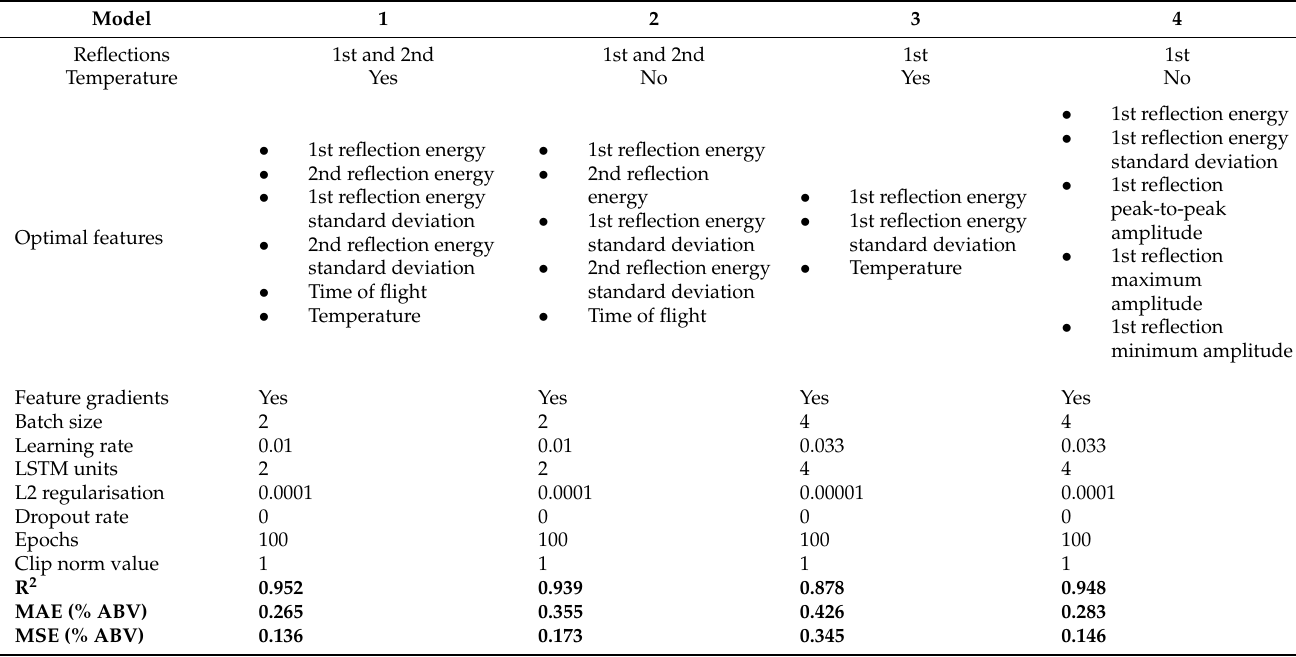
Table 1. Results for the long short-term memory neural network (LSTM) models. MAE: mean absolute error; MSE: mean squared error; ABV: alcohol by volume. The regression metrics for the models evaluated on the test set are highlighted in bold at the bottom of the